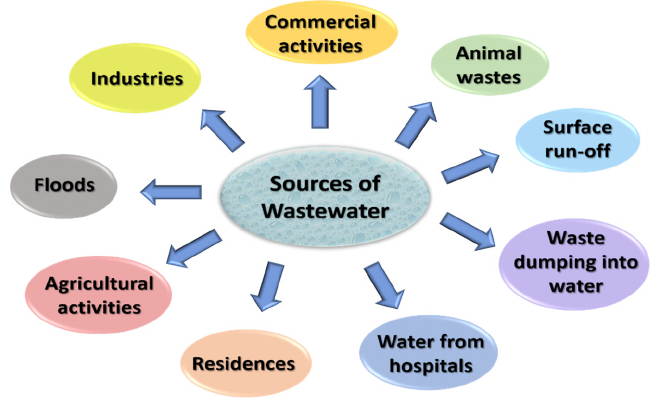
Figure 2. Sources of wastewater.